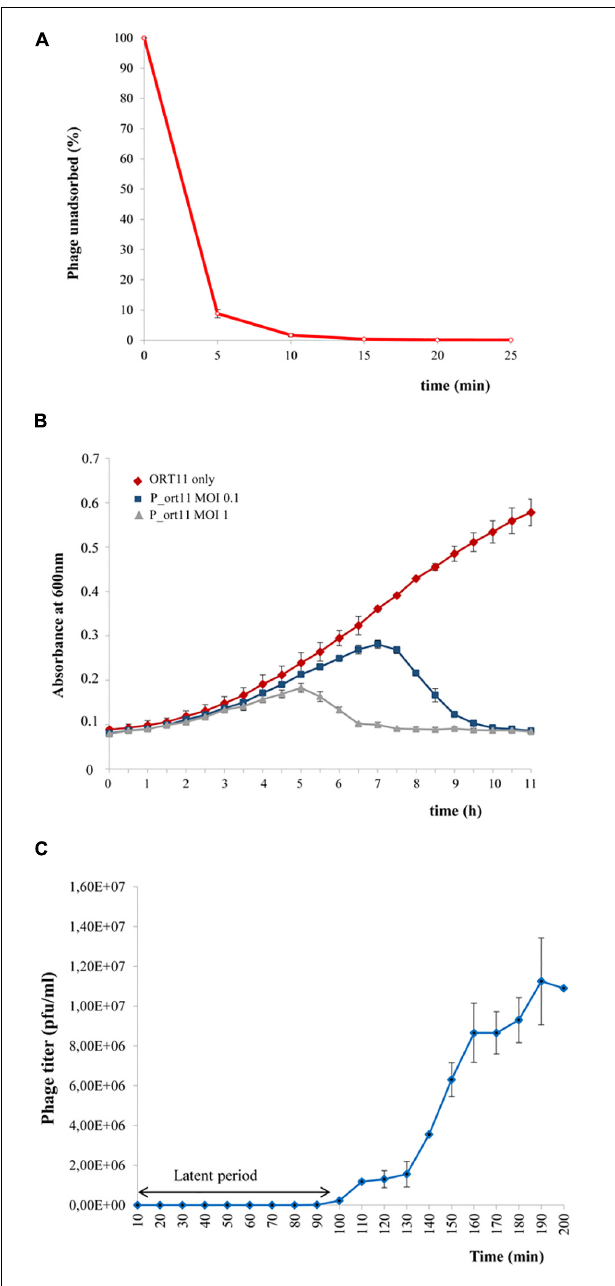
FIGURE 2 | Biological characterization of P_ort11. (A) Adsorption of P_ort11 to ORT11 at a MOI 0.1. The supernatant was titrated at various time points to determinate the amount of phages unadsorbed. (B) S. meliloti ORT11 growth curves in the presence and the absence of P_ort11. Phage was added at MOIs of 0.1 and 1 to ORT11 in the early exponential growth phase (OD600 0.1). (C) One-step growth curve of P_ort11. ORT11 bacteria were infected with a MOI 0.01. Each graph shows an average of three independent experiments, including standard error.